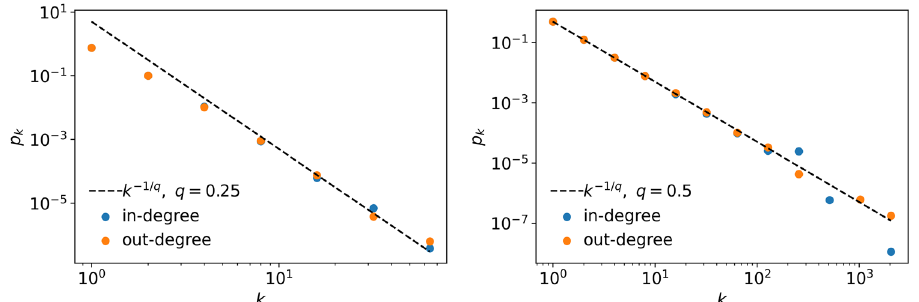
Figure 2. Degree distributions. Distribution of the number of predecessors (in-degree) and successors (out- degree) across activities in networks generated by the duplication-split model, using ( A ) q = 0.25 and B) q = 0.5. The dashed line highlights the power law tail predicted by our calculations.